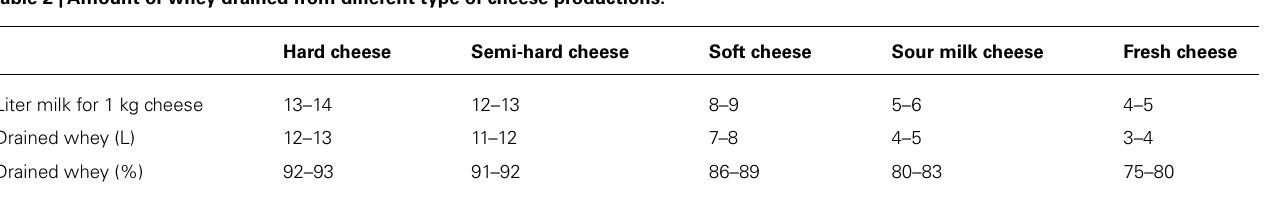
Table 2 |Amount of whey drained from different type of cheese